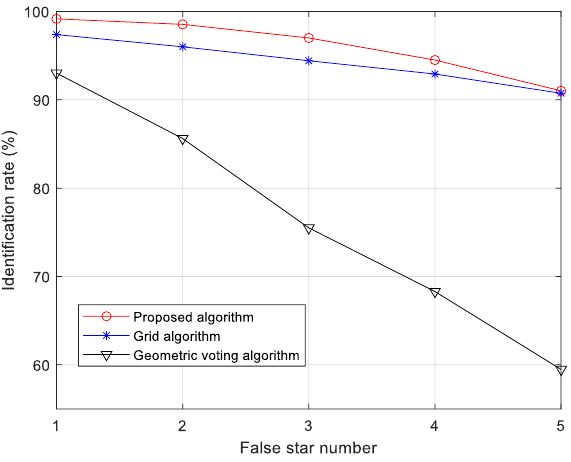
Figure 14. Identification rate versus false star.